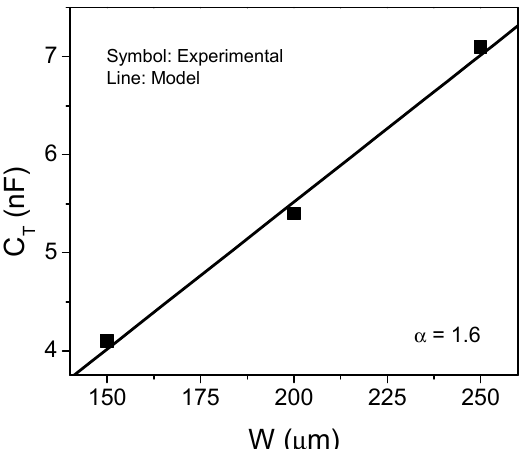
Figure 5. Comparison between measured and simulated capacitance at reference condition for the different fabricated devices. An effective length of 52 cm is obtained.